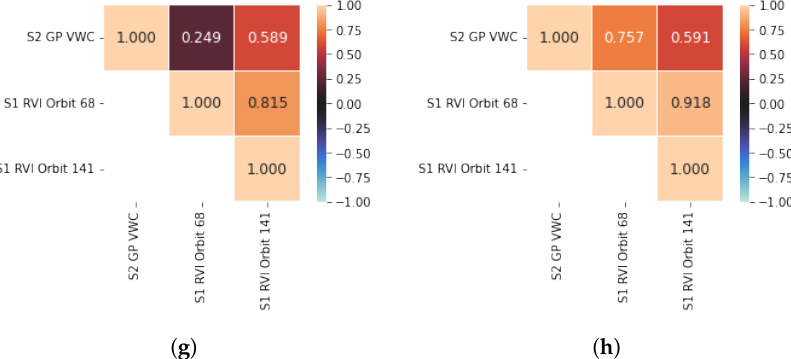
Figure 6. Cross-correlation matrix of the S1 & dataset among the channels of the trained MOGP models. The elements of the matrix’s diagonal show the auto-correlations of each channel in the dataset. MOSM model for wheat 2020 ( a ). CSM model for wheat 2020 ( b ). SM-LMC model for wheat 2020 ( c ). CONV model for wheat 2020 ( d ). MOSM model for wheat 2021 ( e ). CSM model for